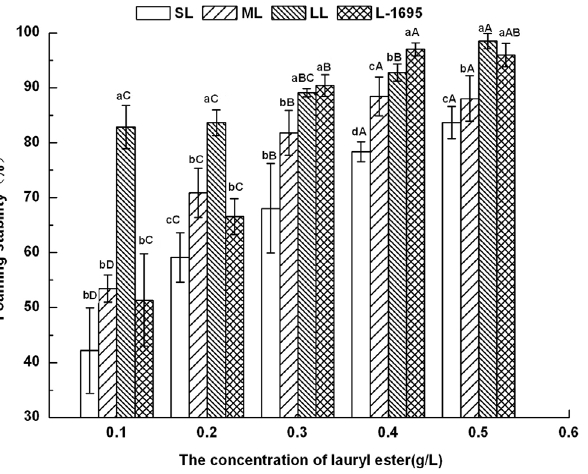
Fig. 2. Foaming stability of different concentrations of lauryl monoesters for 50 min at 25 ˚ C. Upper- case letters indicate comparison with different concentrations of the same surfactant. Lower-case letters indicate comparison with all surfactants with the same